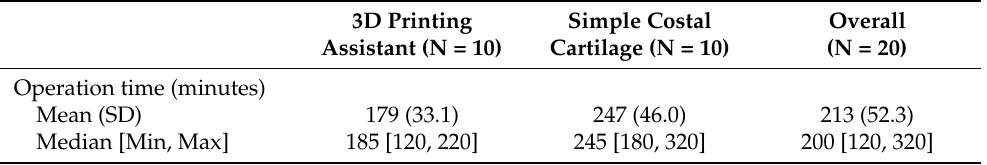
Table 2. The operation time of different groups were recorded below.